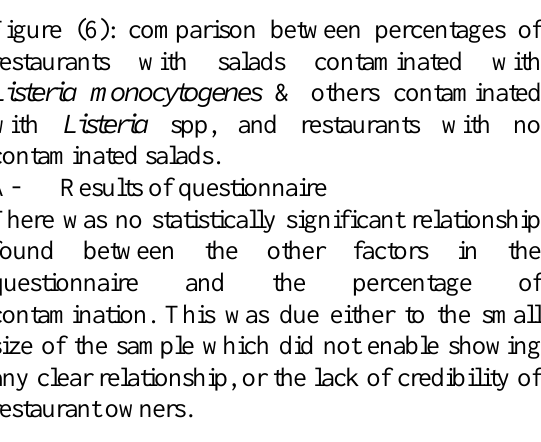
Figure (1): growth of Listeria monocytogenes on ALOA agar Figure (6): comparison between percentages of restaurants with salads contaminated with Listeria monocytogenes & others